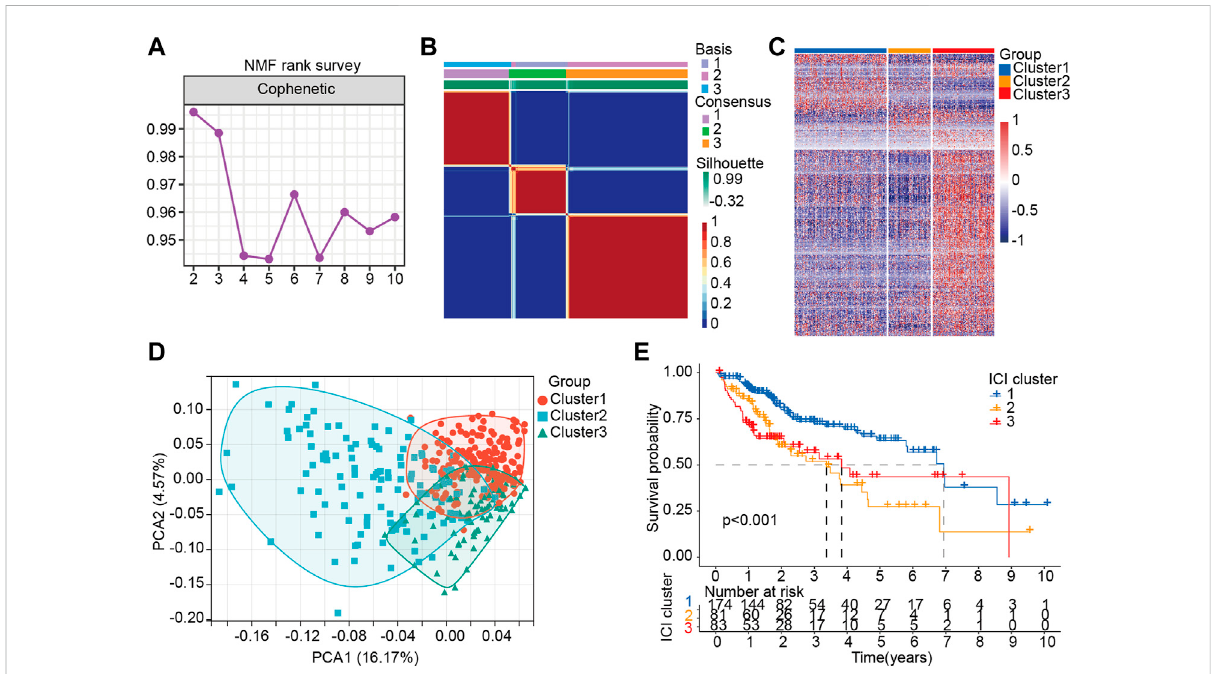
FIGURE 3 Strati fi cation of HCC patients based on the lactate lncRNA. (A) NMF clustering using 426 lactate lncRNAs (k = 2 – 10). (B) The consensus map for k = 3. (C) The difference of LM-lncRNA expression in three groups was analyzed by Heatmap. (D) Principal components analysis (PCA) for patients based on lactate lncRNA expression. Each dot represents a patient, and different colors represent different immune subtypes. (E) Kaplan – Meier curves analysis for the three